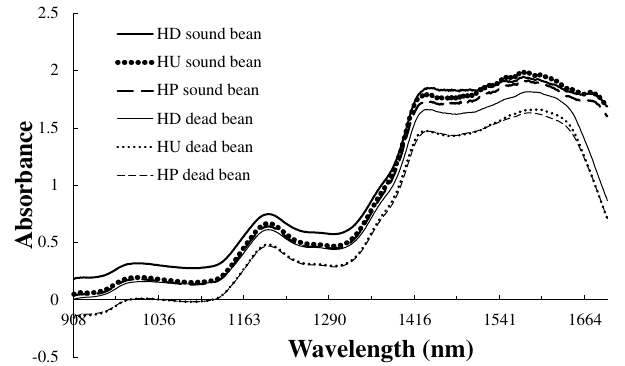
Fig. 3. Average absorbance of mung beans at di®erent hilum orientations (HD: hilum face-down, HU: hilum face-up, and HP: